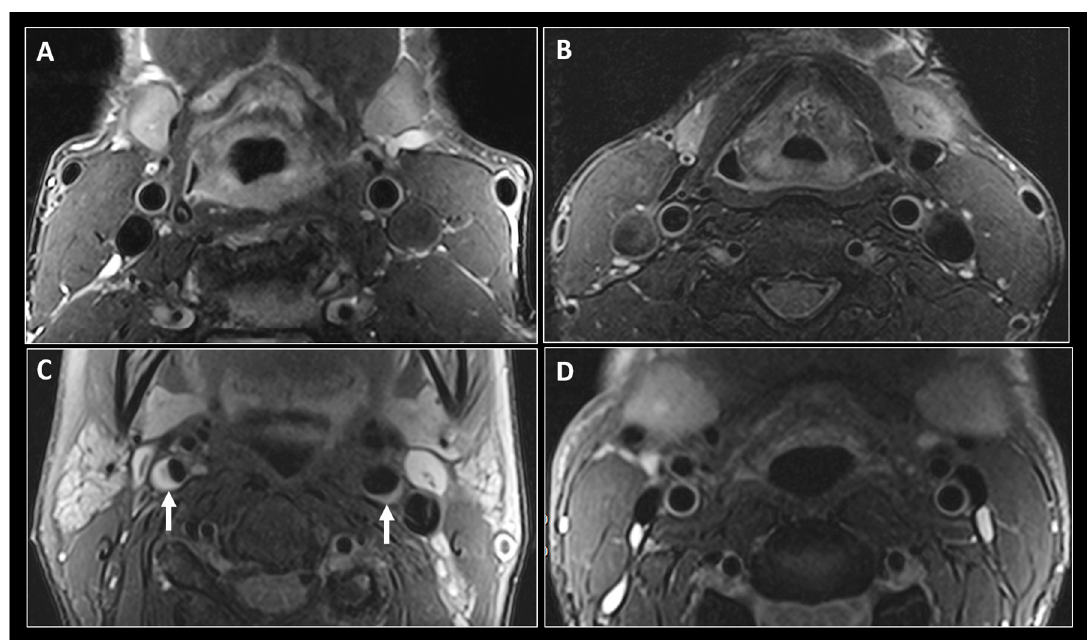
Figure 5. Black-blood MR imaging of the carotid arteries. Fat saturated T2-weighted black-blood MR images at the level of the common carotid arteries in a 56-year-old HIV+ man ( A ) and a 47-year-old HIV − man ( B ). Similar imaging technique at the level of the internal carotid arteries (ICAs) in a 56-year-old HIV+ woman ( C ) shows narrowing of the vascular lumen bilaterally by a plaque (small arrows), more significant on the right side. ( D ) shows similar imaging at the level of ICAs in a 47-year-old HIV negative man with no evidence of atherosclerosis.